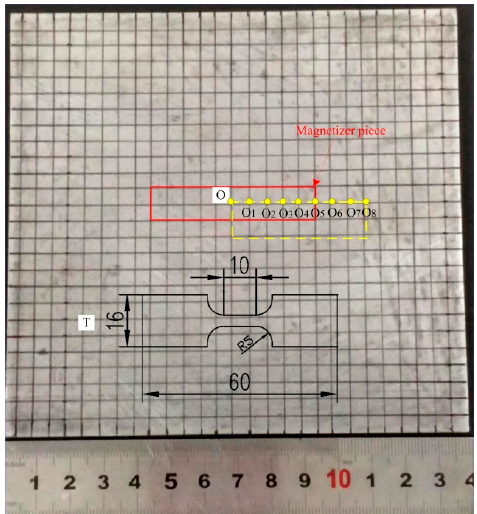
Figure 2. Sample position in the quenched blank. (The red frame: The projection position of the magnetizer piece; O 1 –O 8 on yellow frame: Metallographic sampling points location; O and T: Tensile specimen size and location).